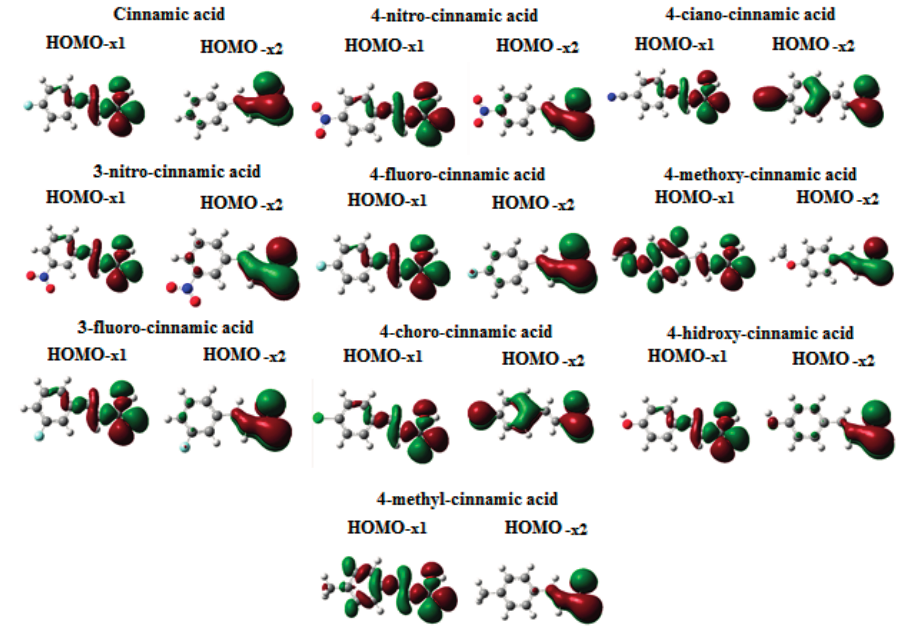
Figure 2. Surface plots for HOMO-x 1 and HOMO-x 2 molecular orbitals for the